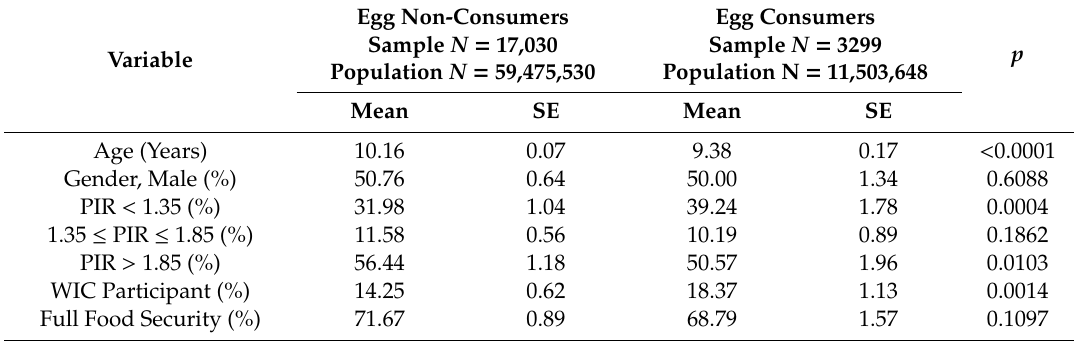
Egg Consumers Sample N =